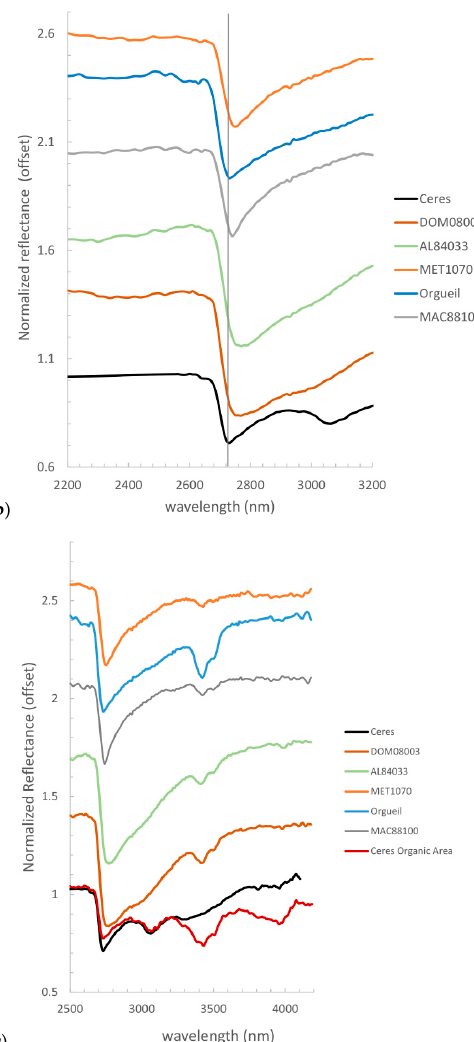
Figure 2. ( a ) Comparison between the spectra of Ceres and heated carbonaceous chondrites (Ceres from [24]; Heated carbonaceous chondrite (CC) from [31], SShade database). ( b ) Zoom in the region of the phyllosilicate absorptions. Comparison between the spectra of Ceres and heated carbonaceous chondrites (Ceres from [24]; heated CC from [31], SShade database). ( c ) Comparison between the spectra of Ceres (average ‐ black spectrum, organic ‐ rich region ‐ red spectrum) and heated carbonaceous chondrites (Ceres from [24]; heated CC from [31], SShade database).